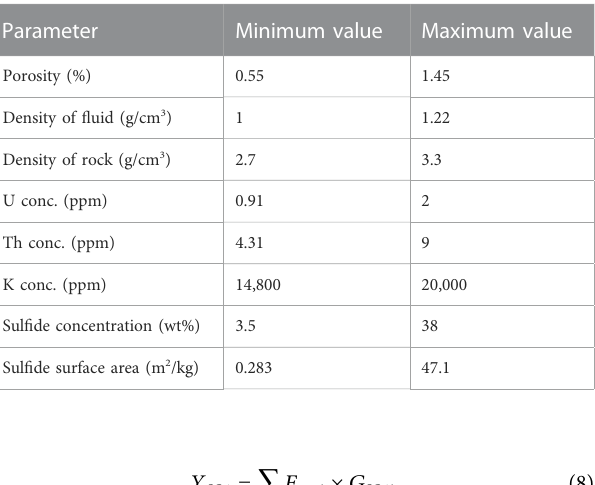
in Table 1: 1. Porosity, 2. Density of fl uid, 3. Density of rock, 4-6. Concentrations of radioelements (U, Th, K), 7. Sul fi de